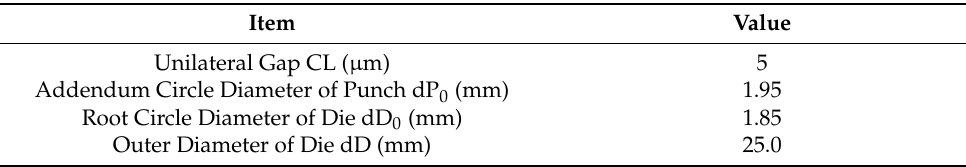
Table 2. Main parameters of blanking device.